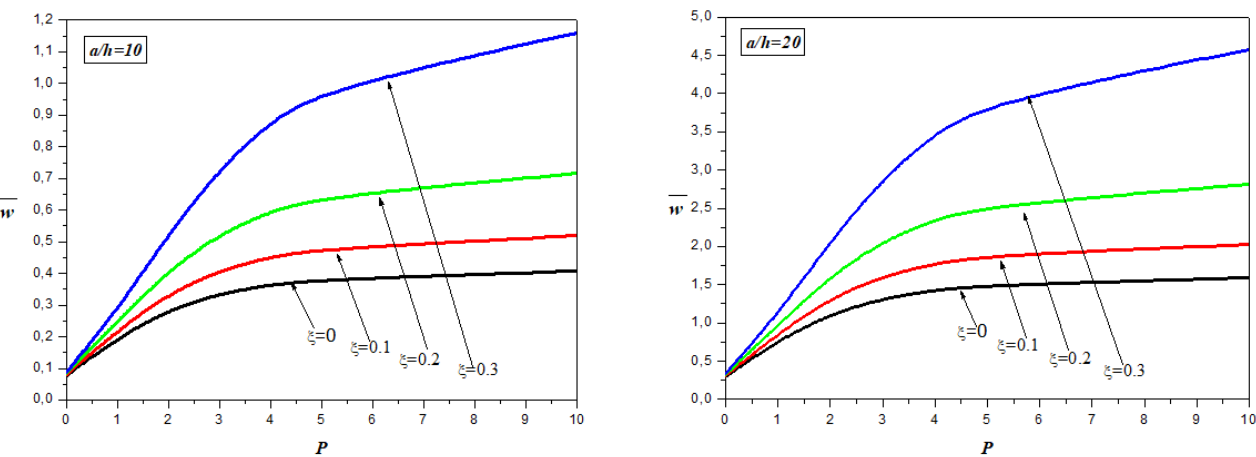
Figure 2: Displacement variation as a function of the power index “ p ” and the volume fraction of porosity of a FG plate.